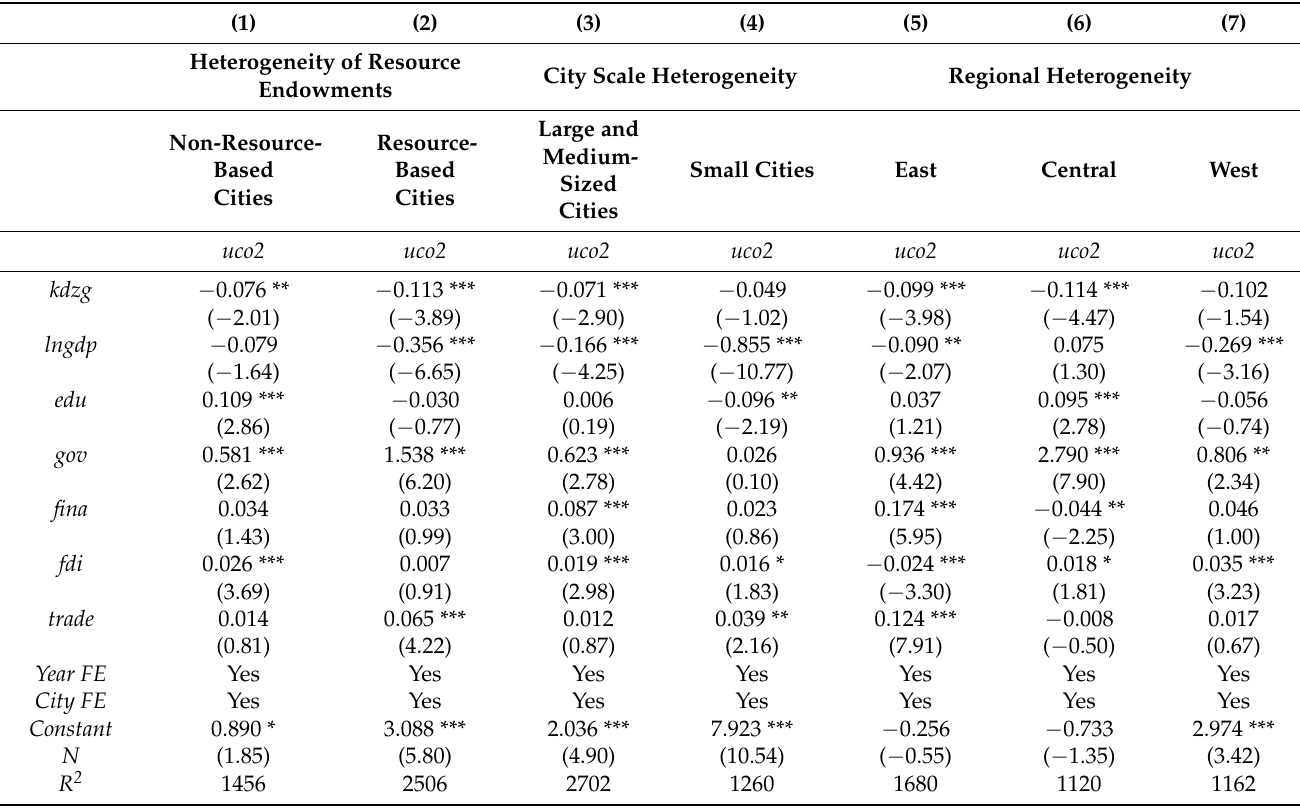
Table 5. Heterogeneity of city characteristic